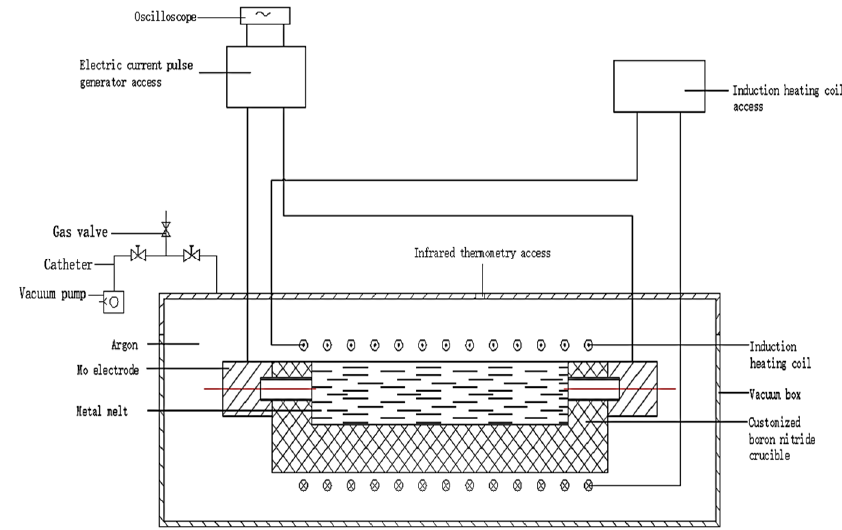
Figure 1. Melt smelting device under pulse current.